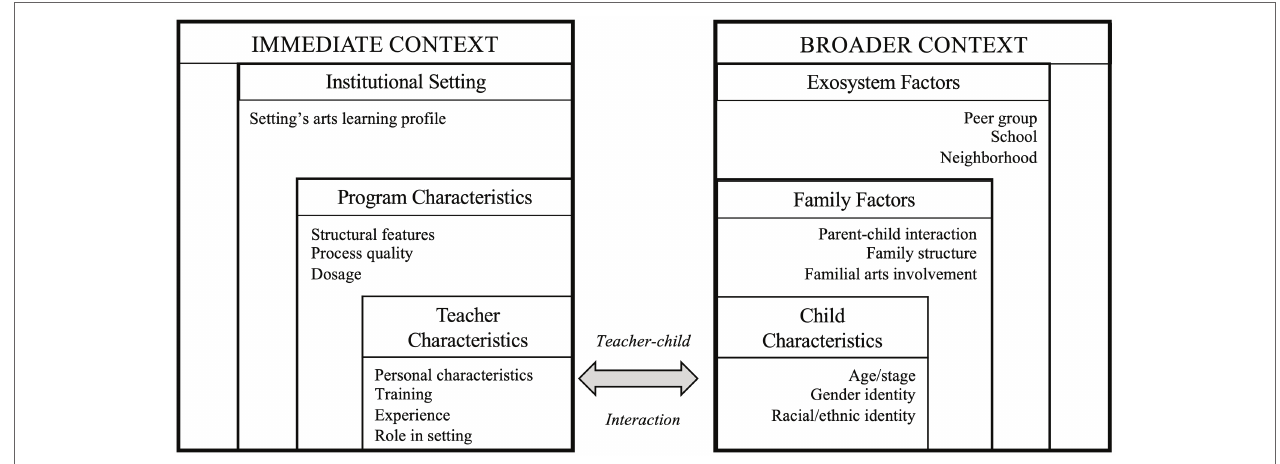
FIGURE 1 | Graphical summary of immediate and broader contextual factors that may promote or constrain the benefits of arts education programs or experiences on children’s socioemotional